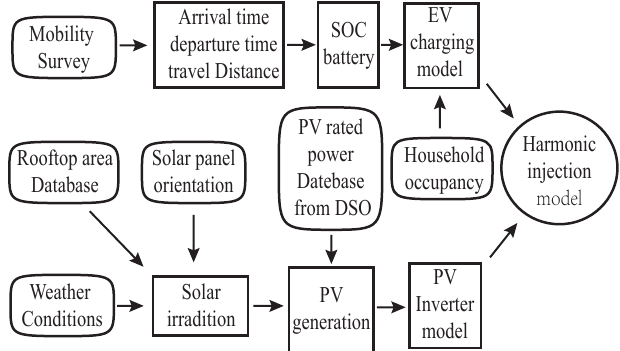
Figure 3. The modeling approach for electric vehicle (EV) and PV. SOC : state of charge; and DSO: distribution system